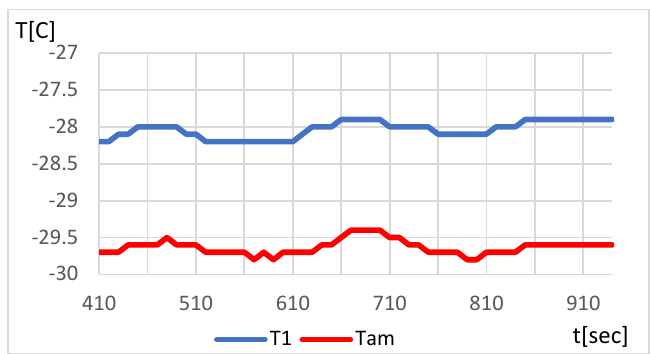
Figure 25. Temperature variations: on the switch-rail foot (T1) and in the climatic chamber ( T am ). Temperature changes on the switch-rail foot (T1) exhibited a sudden drop at 33 min (Figure 19a). This was most likely caused by shifting of measurement wires and loss of precise contact.